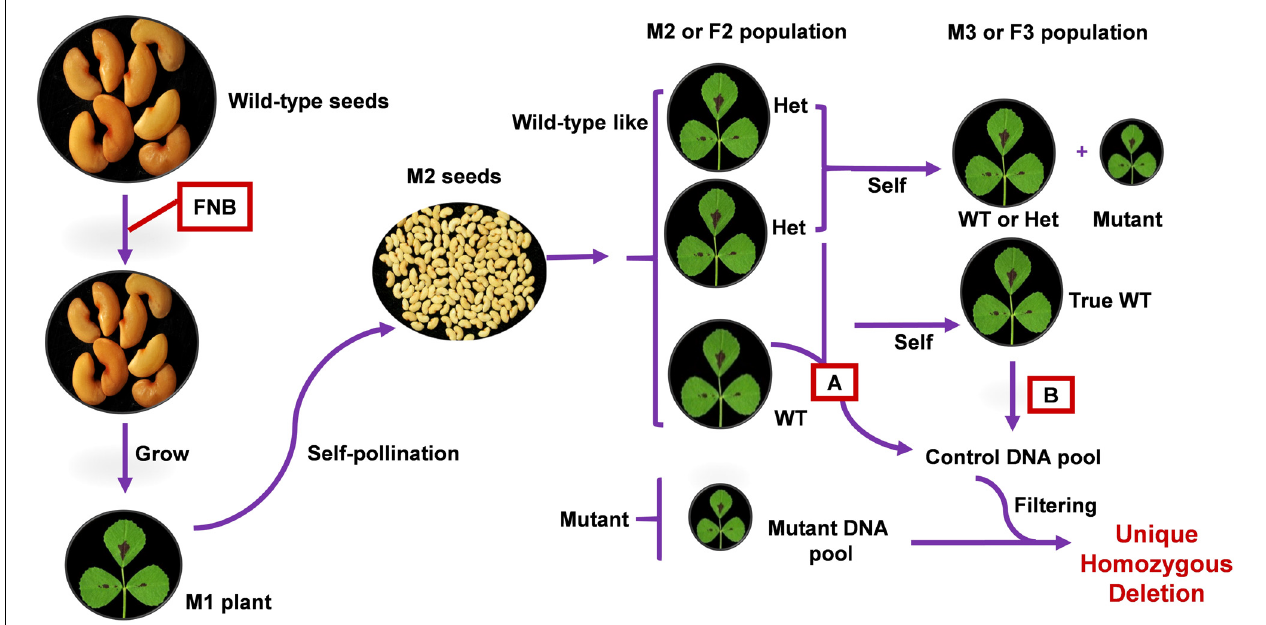
FIGURE 1 | Simplified schema for application of FNBtools to M. truncatula FNB population. Once a mutant is isolated from a segregating M2 progeny, it can be directly used as the mutant pool. Alternatively, the mutant can be backcrossed with wild-type to reduce background noise. In this scenario, segregated mutant plant from a F2 progeny can be used as the mutant pool. Pooling strategy A represents the control DNA pool from wild-type and heterozygous individuals in the segregating M2 or F2 progeny. With this control pool, only homozygous deletions commonly existing in the control pool and the mutant pool are filtered out from the mutant pool. Pooling strategy B represents the control DNA pool from true wild-type individuals in the M3 or F3 population. With this control pool, both heterozygous and homozygous deletions commonly existing in the control pool and the mutant pool are filtered out from the mutant